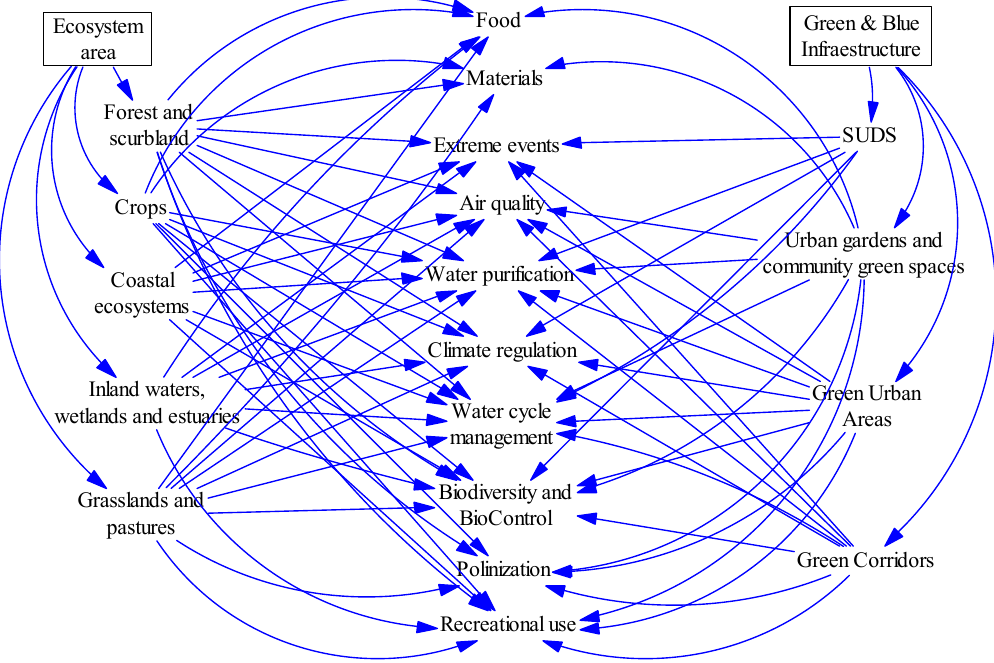
Figure 7. Ecosystems and ecosystem services system (own elaboration).